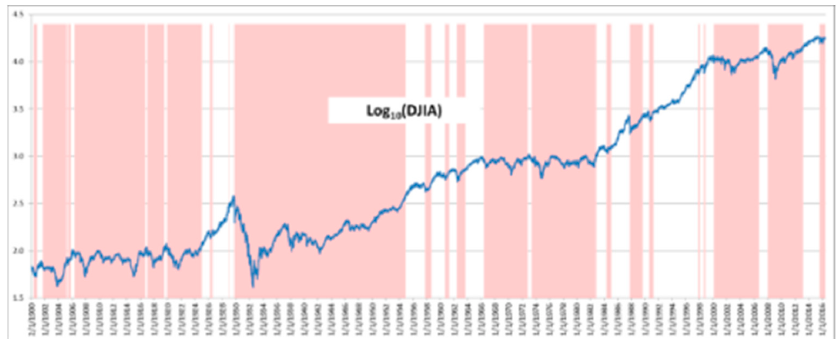
Figure 7. Periods of DJIA decline. Source: Authors’ processing is based on data available http://stooq.com/ (accessed on 20.07.2017).